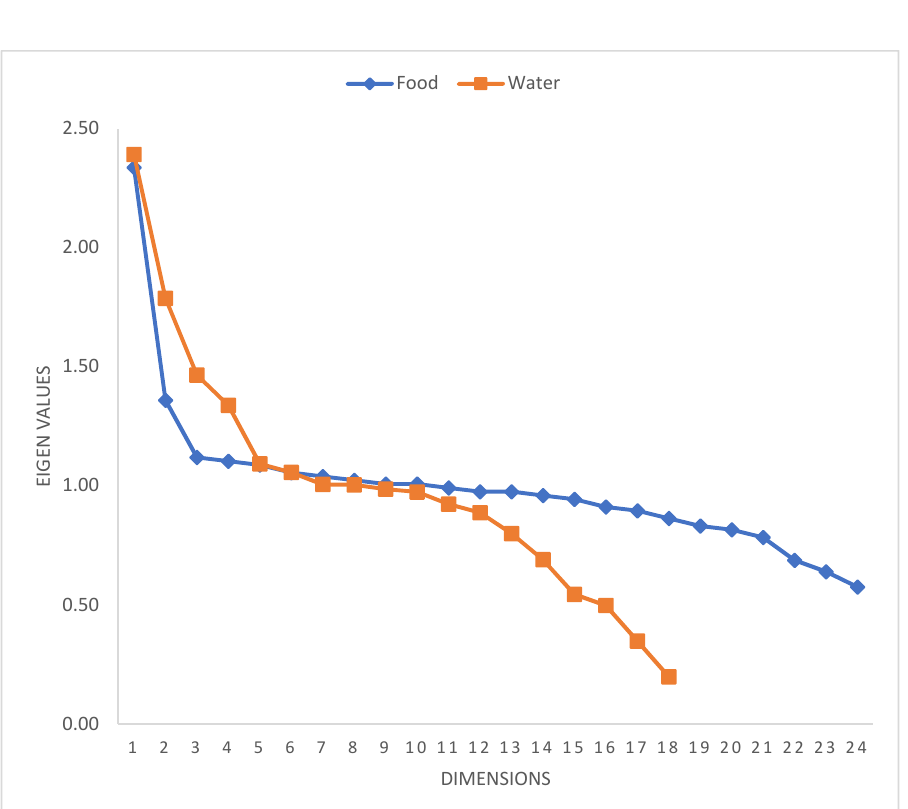
* All socio-demographic variables had <5% missing data unless otherwise stated. ** All variables represent complete data as n(%) unless otherwise stated. 1 Missing data >5%. - Empty cells imply that the variables were Int. J. Environ. Res. Public Health 2021 , 18 , x not described for that sample.